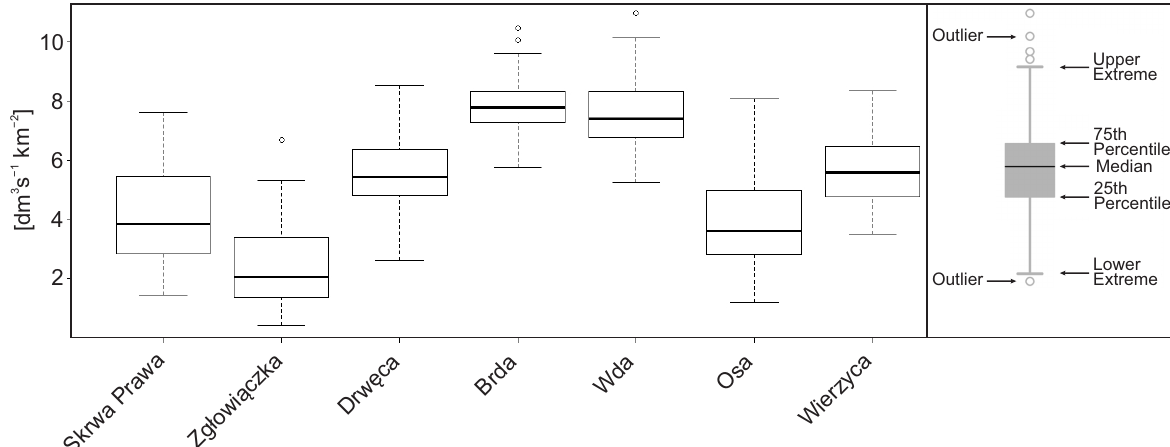
Fig. 2. Basic parameters of the distribution of mean annual specific discharges of the studied rivers in 1954–